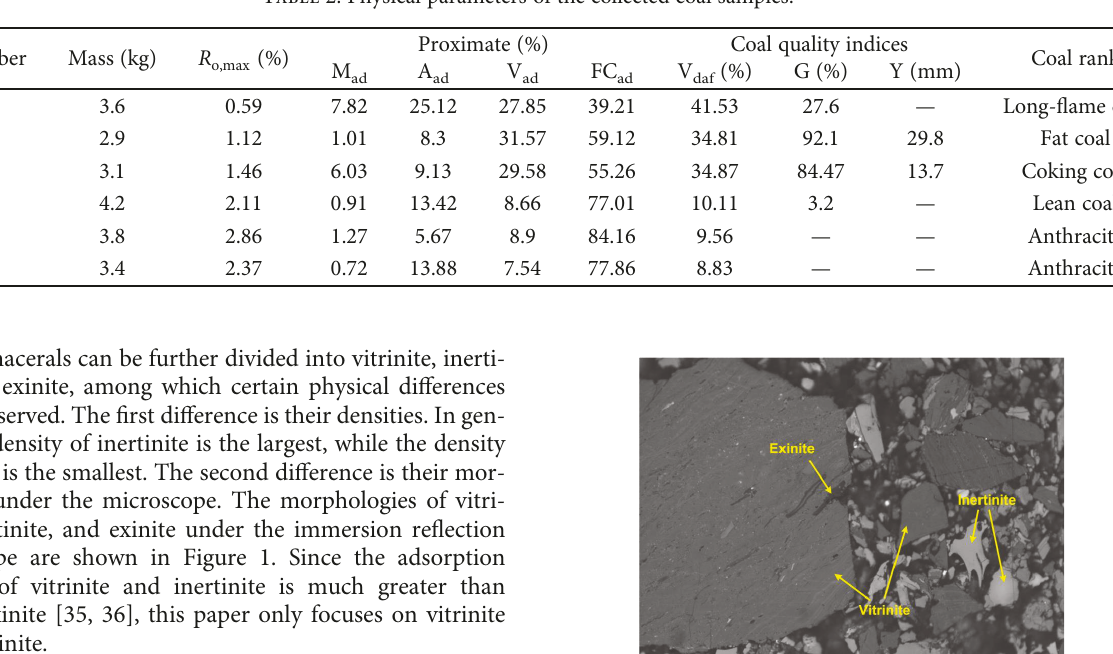
Table 2: Physical parameters of the collected coal samples.